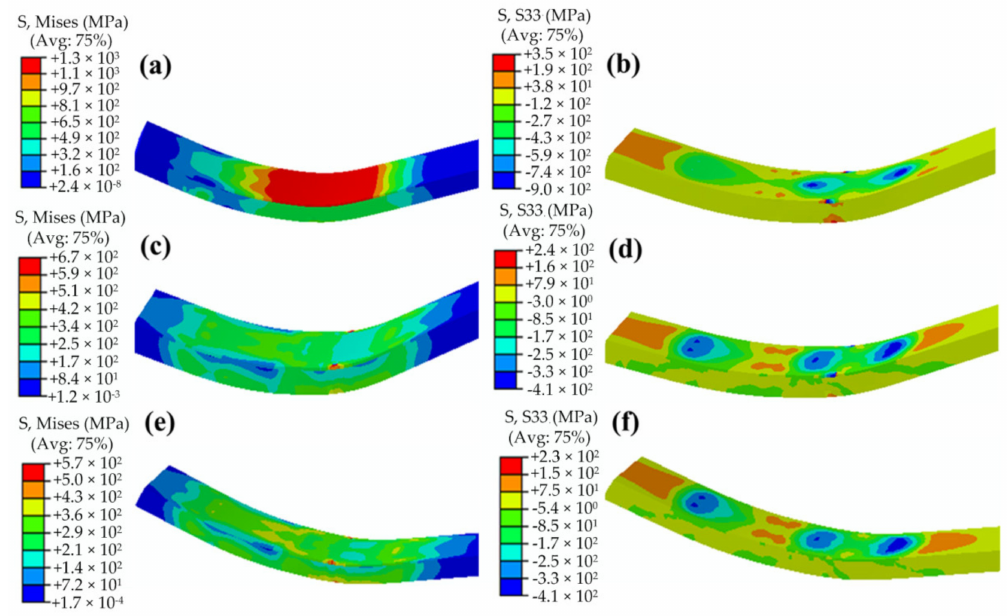
Figure 13. Mises and axial stress contours of the process of the JCO forming: ( a ) Mises stress contour after loading, ( b ) axialstress contour after loading, ( c ) Mises stress contour after the die upward pressing, ( d ) axialstress contour after the die upward pressing, ( e ) Mises stress contour after the plate moves forward, and ( f ) axial stress contour after the plate moves forward.